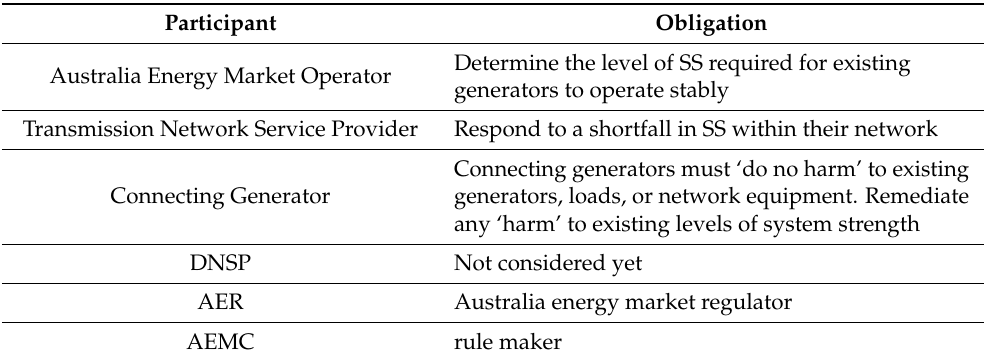
Table 2. System Strength Responsibilities under NER [19,25].